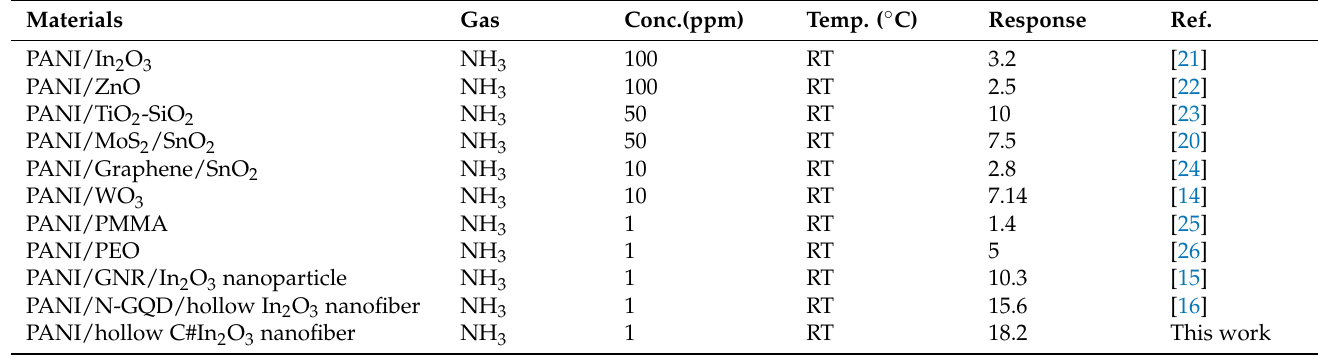
Table 1. A comparison of NH 3 -sensing properties of the PANI/hollow C#In 2 O 3 nanofiber sensor established here, and the other sensors reported